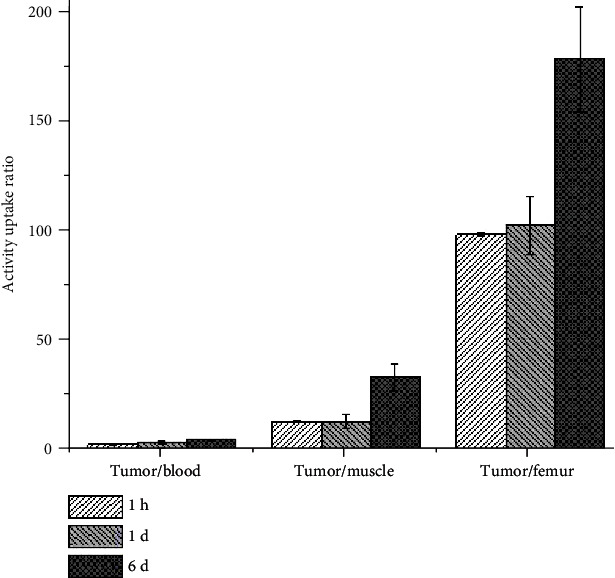
Variation of target to nontarget ratios with time for 177Lu-acrdine complex.